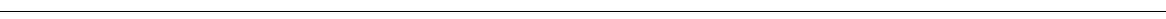
Fig. 8 Validation of defense-related genes pre-mRNAs splicing ratio by qRT-PCR. a – c Selected gene splicing ratio and gene expression was determined by RNA-seq and qRT-PCR analyses. The GmNAC and a GmWRKY predicted transcription factor genes are subject to AS in the GmSKRP1 and PsAvr3c overexpressing lines, whereas the COP9 signalosome complex subunit gene does not. The left panel shows wiggle plots of RNA-seq data with the schematic gene model, the asterisks indicate the premature stop codon. The black and blue arrows indicate the primers that are used to measure the intron splicing ratio and gene relative expression, respectively. The spliced primers that cross exon-exon junctions are shown with dashed lines over the intron. Splicing ratio was calculated by determining the level of spliced RNA normalized to the level of unspliced RNA. Values on the Y -axis indicate reads per 20 million (RP20M). The right panel shows the selected genes splicing ratio of introns in fi ve different overexpression hairy roots and six different infection roots. Pre-mRNA intron splicing ratio from three replicates are normalized and presented as means ± standard errors (** P < 0.01; one-way ANOVA). d Schematic representation of PsAvr3c virulence function. In absence of PsAvr3c effector (left), GmSKRPs are consistently degraded by 26S proteasome probably for maintaining protein turnover. SKRPs associate with spliceosome components to regulate pre-mRNA splicing. Proper splicing of defense- related genes contribute to plant resistance. In the presence of PsAvr3c effector and the absence of Rps3c (right), PsAvr3c associates and stabilizes SKRPs in plant nucleus. Increased level of SKRPs results in large scale of pre-mRNA alternative splicing. In particular, some defense-related genes generate alternative splicing isoforms, thus the PsAvr3c effector reprograms host pre-mRNA splicing to suppress plant